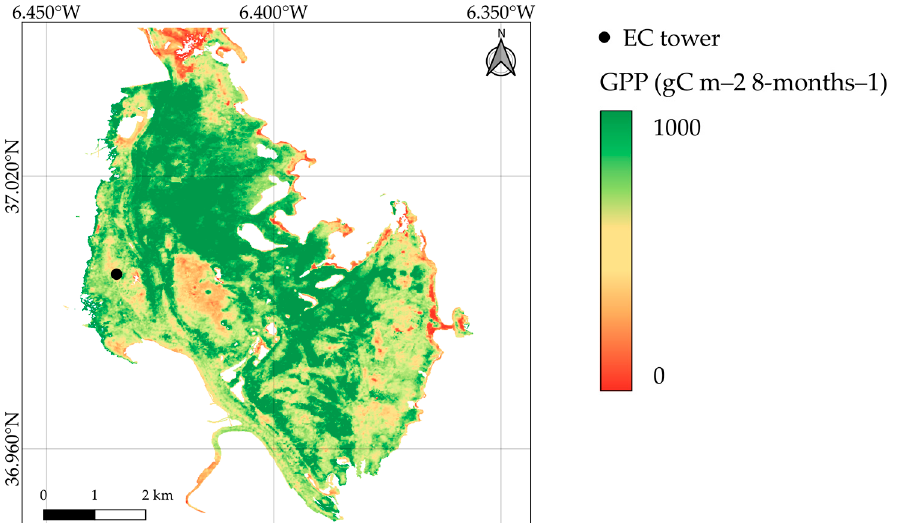
Figure 16. GPP map for the period October 2020 to May 2021 over the study area. When compared to in situ measurements at the Duque Fuente station, a MAE equal to 9.68 gC m − 2 month − 1 , an RMSE equal to 13.81 gC m − 2 month − 1 , and a Sest of 0.23 were